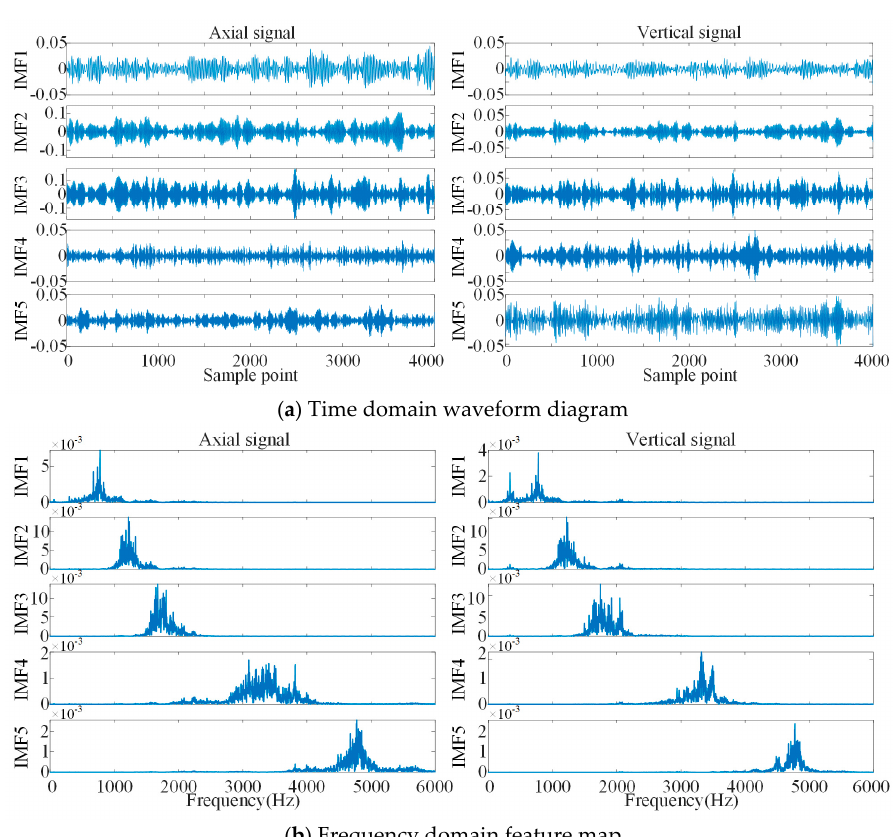
Figure 11. Decomposition results of bearings with rolling element